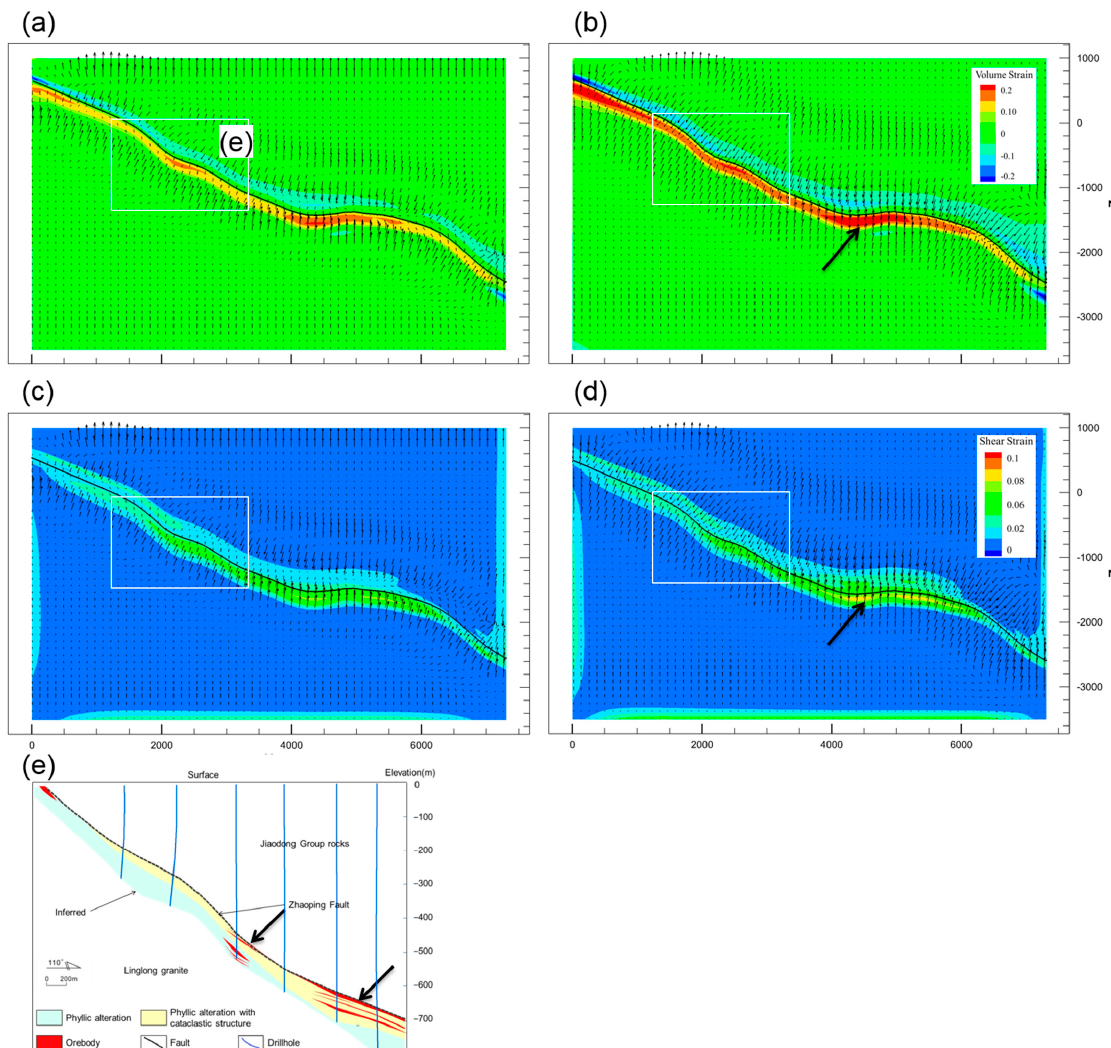
Figure 9. The volumetric strain, shear strain distribution, and detailed fluid flow vectors at a strain rate of 10 − an s − s . In the figure, the rectangular box is the scope of the cross-sections; thick arrows indicate areas of intense strain or mineralization; the vector arrows represent the Darcy flux and are used to indicate the direction of flow. ( a ) 0.5% volumetric strain, ( b ) 1.0% volumetric strain, ( c ) 0.5% shear strain, ( d ) 1.0% shear strain, and ( e ) corresponding geological